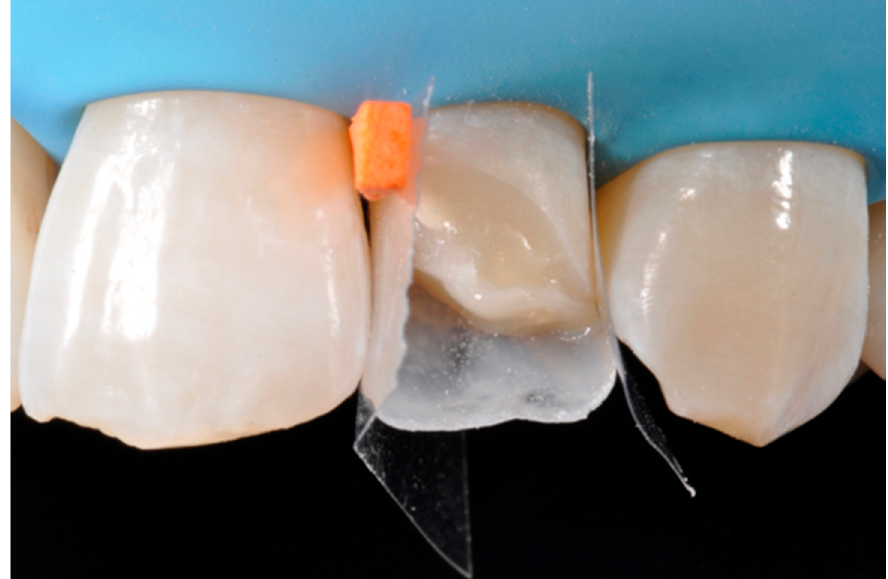
Figure 23. Frame is completed with interproximal matrices. Reprinted from Restauri diretti nei settori anteriori, G. Paolone, S. Scolavino, © 2021, with permission from Quintessence Publishing Italy.